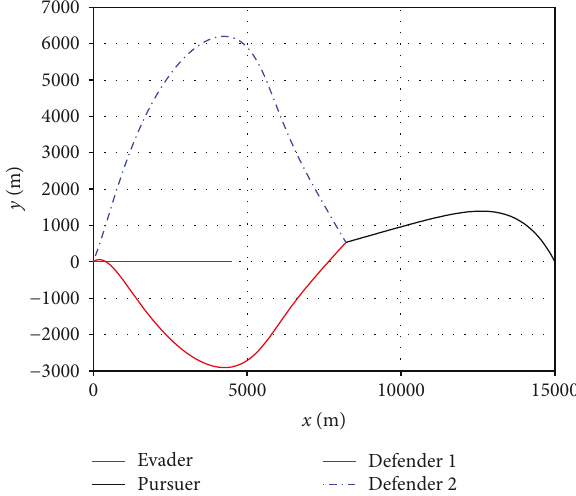
Figure 14: Four aircraft fl ight trajectories (two-side intercept without cooperation of Evader).